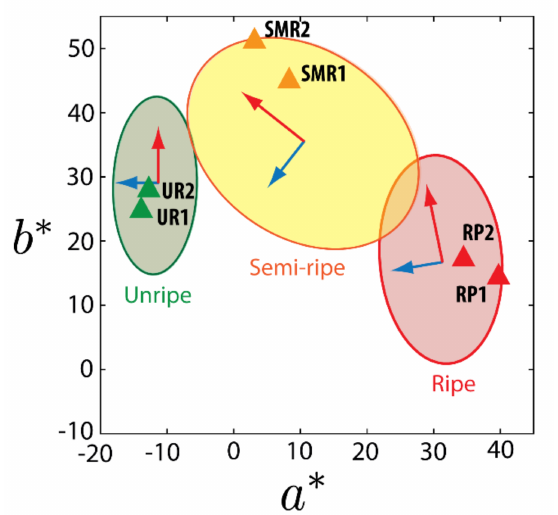
Figure 2. Ripening stage classifications and location of the measured coffee